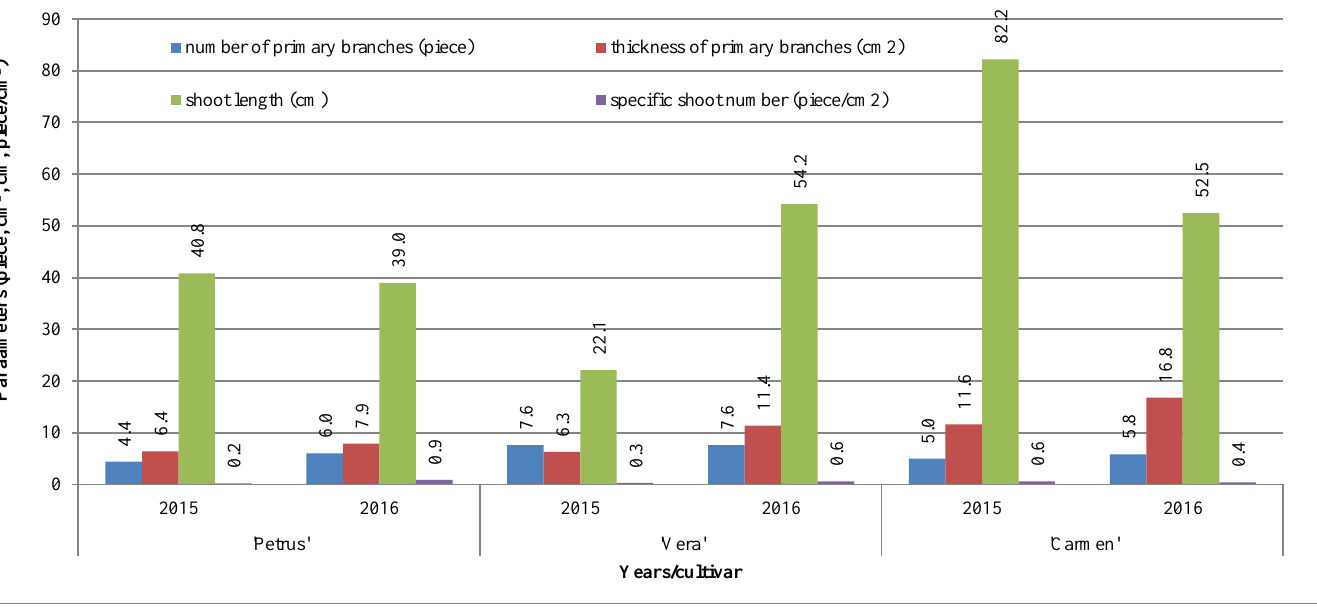
Figure 5. Parameters of shoots and branches on Spanish bush canopy (Debrecen – Pallag,